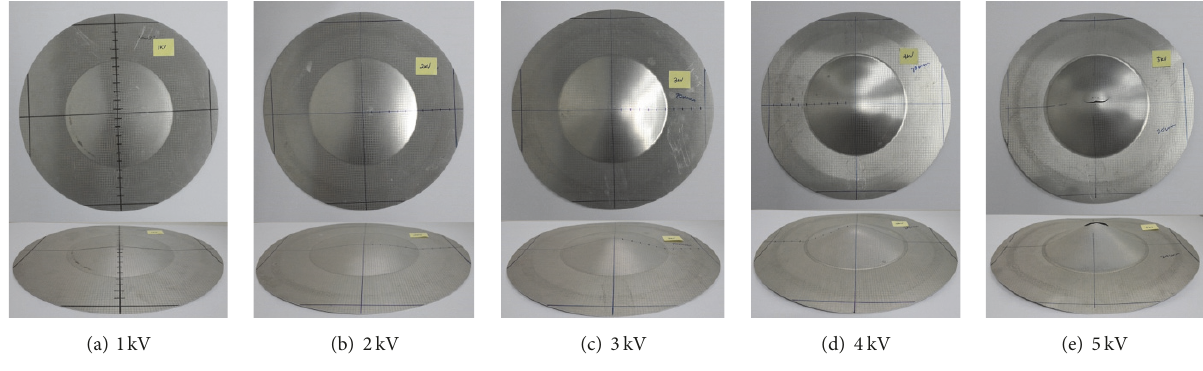
Figure 7: Workpieces after